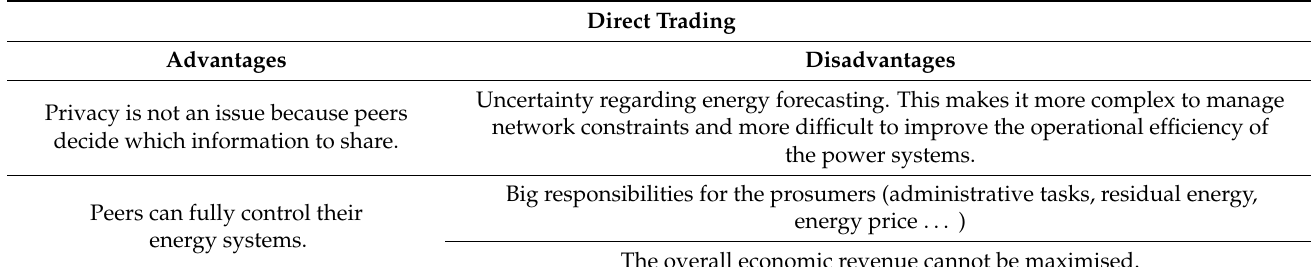
Table 4. Advantages and disadvantages—direct trading P2P-ET market. Table based on own interpretation from Section 2.2.2.